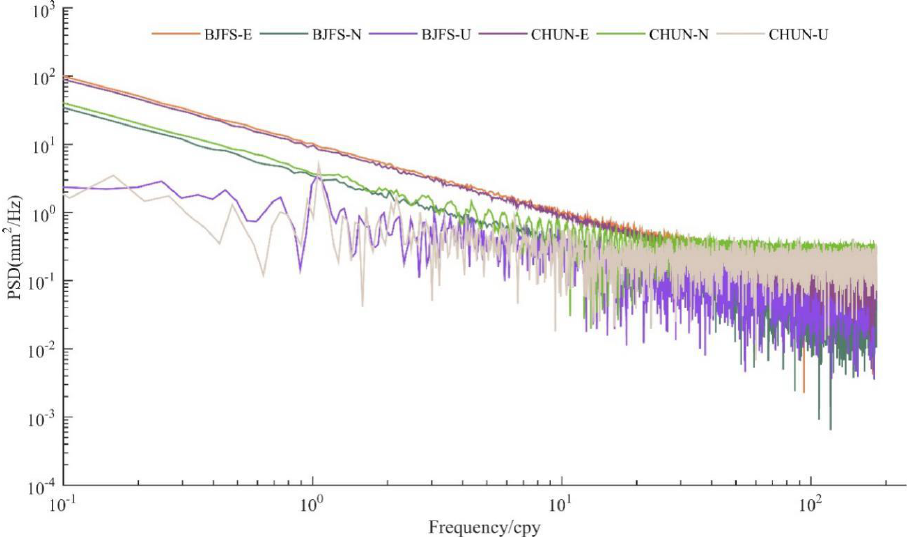
Figure 7. Power spectral density (PSD) of three-direction time series at BJFS and CHUN (ChangChun GPS Station) from 1999 to 2019. Remote Sens. 2020 , 11 , x FOR PEER REVIEW